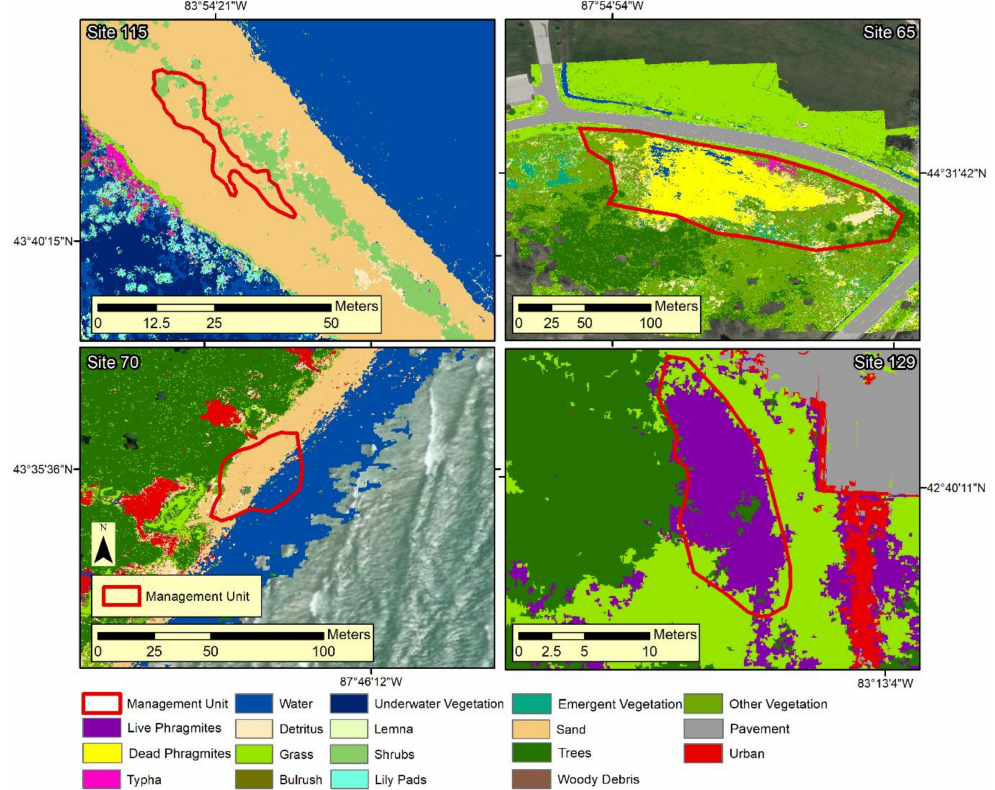
Figure 9. Overview classifications at four UAV collection